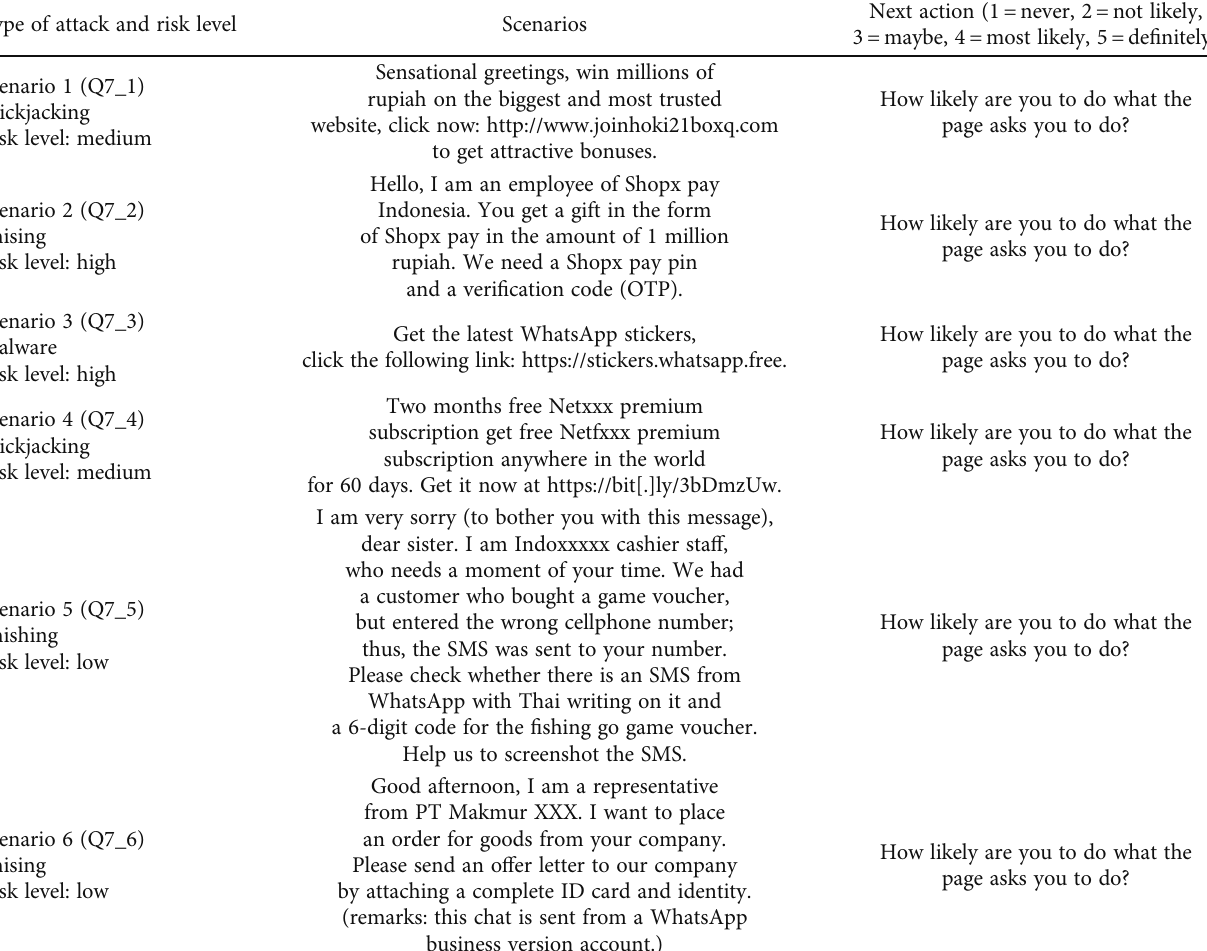
Table 1: Susceptibility instruction and scenarios. Instructions: read carefully the scenario below. Each scenario describes a situation that commonly occurs when we surf in cyberspace. You are asked to state the action or reaction you are most likely to take when faced with the scenario. The reaction that is measured is the likelihood that you will carry out the desired follow up in the scenario; it can be in the form of fi lling in the data or clicking the next button. Your honesty when fi lling out our survey is very helpful, and there are no right or wrong answers in each of these